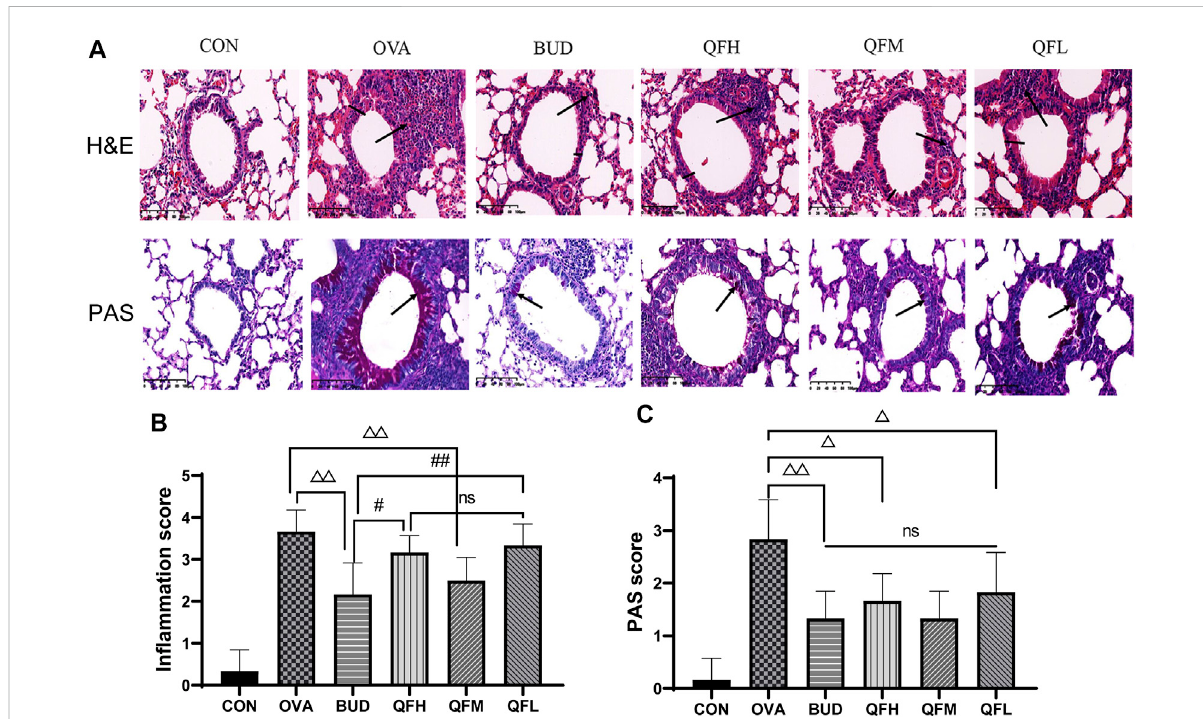
FIGURE 2 Effect of Qingfei oral liquid (QF) on pulmonary pathology in ovalbumin (OVA)-induced asthmatic mice. (A) Representative hematoxylin and eosin (H&E) staining were performed to observe airway in fl ammation in asthmatic mice (200×; the black arrows indicate the aggregation of in fl ammatorycells, andtheblackvertical lineindicatestheairwaywallthickness).Periodicacid-Schiff(PAS)stainingindicating themucus-producing goblet cells around the small airways (200×; similar to the purple area indicated by the black arrow). (B) In fl ammation scores are based on H&E staining. (C) ThePASscoresindicating themucus-producinggobletcellsaroundthesmallairways.Data areexpressed asmean±standarddeviation (SD)(one-wayANOVAfollowedbyTukey ’ stest). n =6, △ p ≤ 0.05vs.theOVAgroup, △△ p ≤ 0.01vs.theOVAgroup; # p ≤ 0.05vs.thebudesonide(BUD) group, ## p ≤ 0.01 vs. the BUD group, ns: no